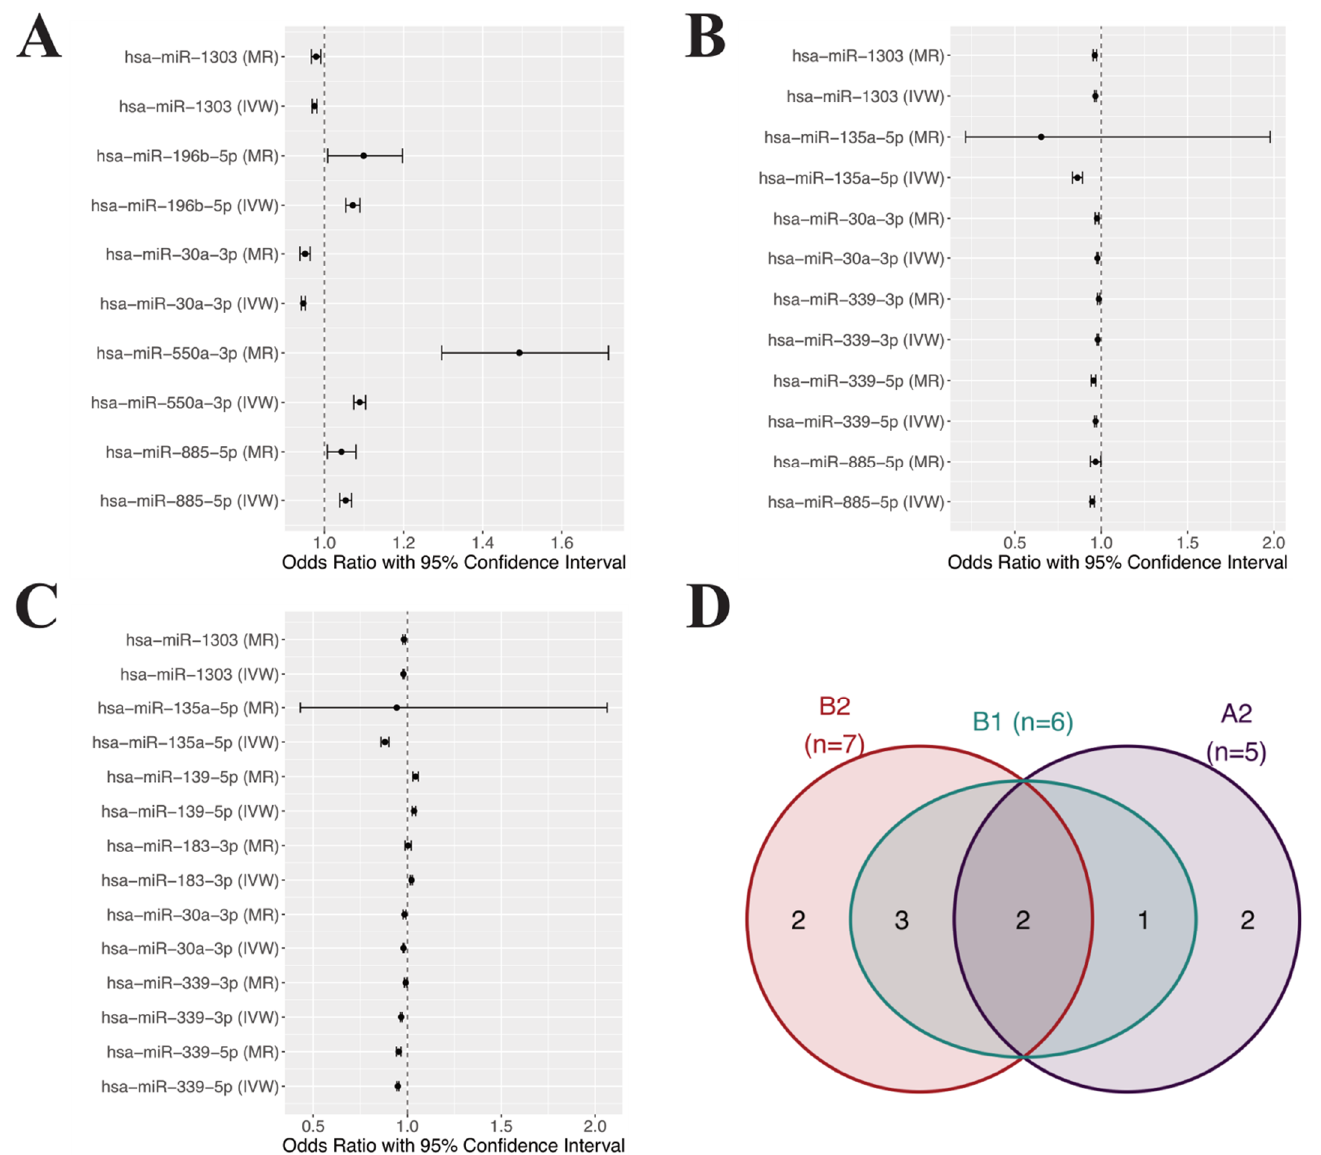
Figure 2. Protective and harmful effects of miRNAs on COVID-19 severity. The circle indicates the point estimate of OR and the whisker shows its 95% confidence interval. ( A ) Significant causal relationships identified in the A2 phenotype group. ( B ) Significant causal relationships identified in B1 phenotype group. ( C ) Significant causal relationships identified in B2 phenotype group. ( D ) Overlapping putatively causal miRNAs between the three phenotype groups. Numbers inside the circles represent the number of overlapping or unique miRNAs. MR: MR-Egger, IVW: Inverse variance weighted MR.